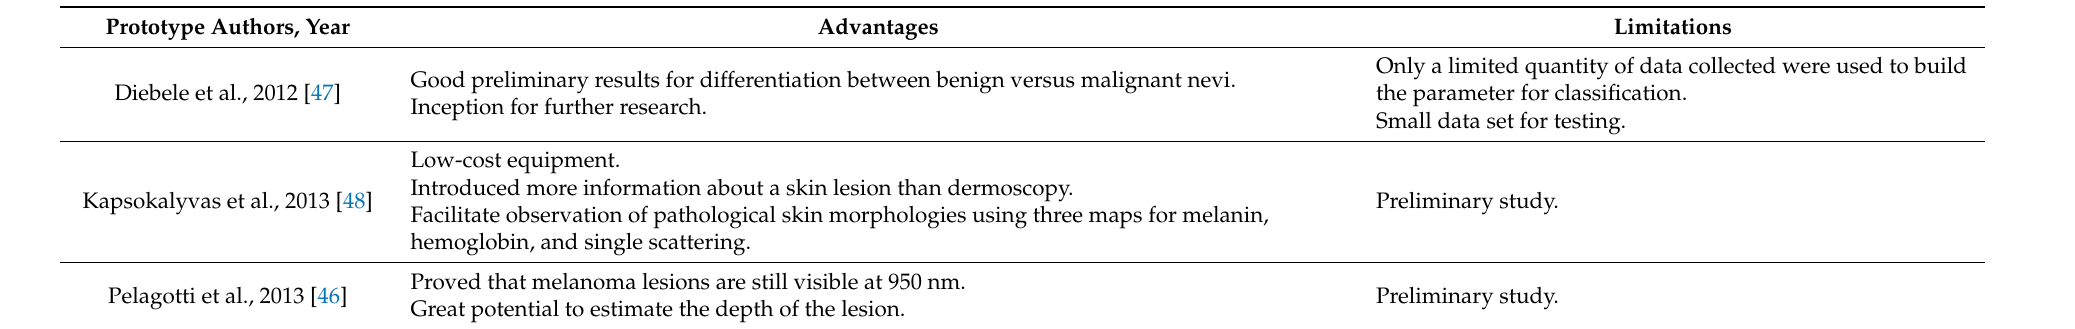
Table 6. Advantages and limitations of multispectral imaging prototypes developed for